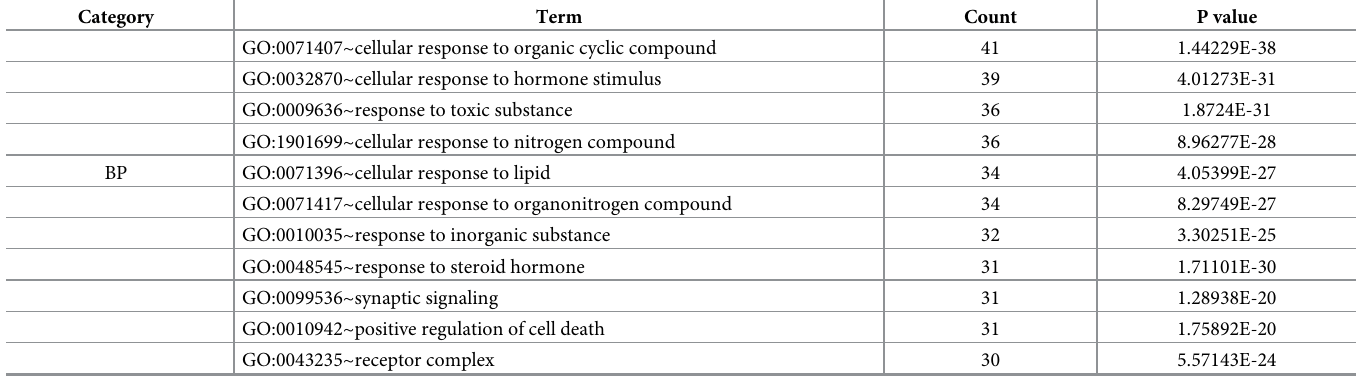
Table 3. GO enrichment